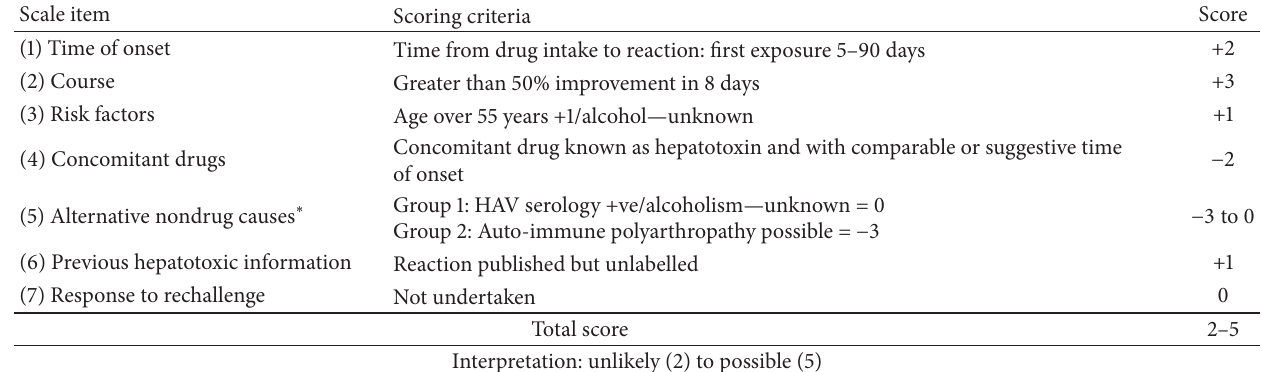
Table 1: CIOMS/RUCAM score for the case report on acute hepatitis induced by